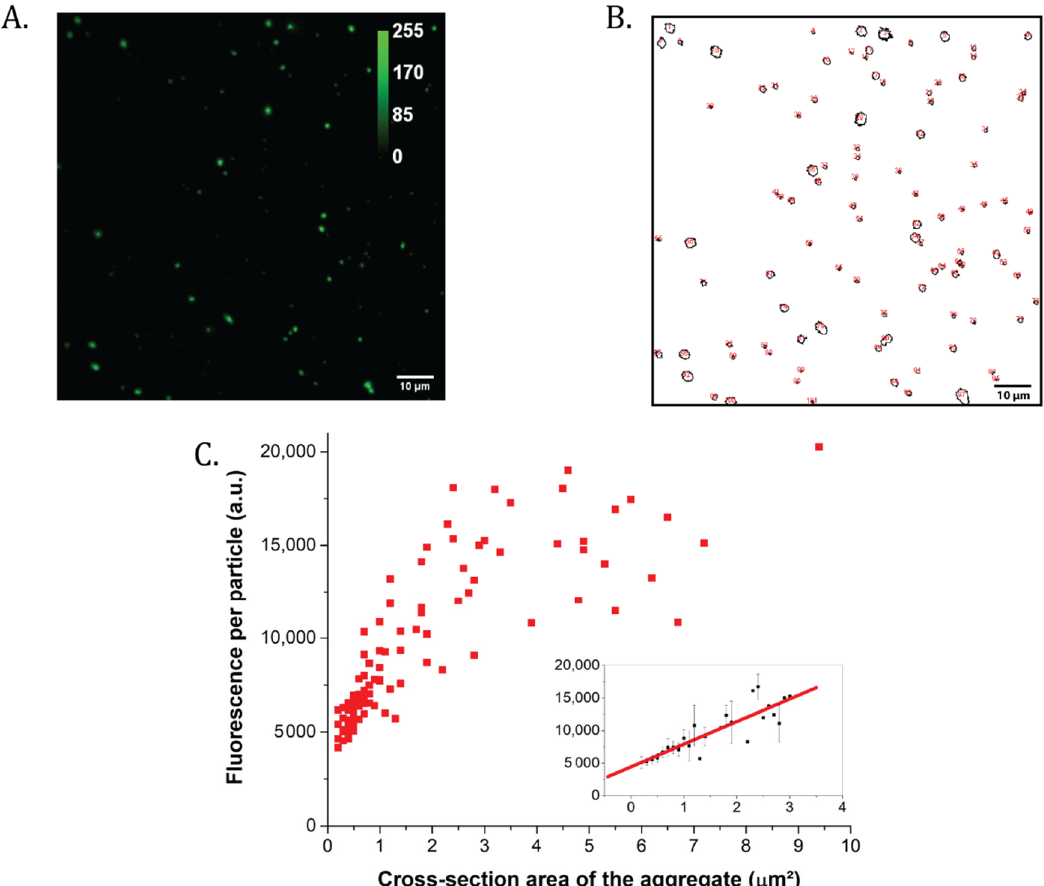
Figure 4. Analysis by confocal microscopy of the large LHCII particles formed below 25 µ M DDM and pH 5.0. ( A ) Confocal microscopy picture of the LHCII particles precipitated at the bottom of the well. The fluorescence is presented in arbitrary units. Scalebar: 10 µ m. ( B ) Analysis of the confocal picture from (A), with the cross-section of each detectable aggregate circled. ( C ) Fluorescence intensity per LHCII particles as a function of the measured cross-section area. Insert: zoom of the section between 0 and 3 µ m 2 , with average particle fluorescence values and standard deviations. Red line: straight line fitting of the data; R 2 =